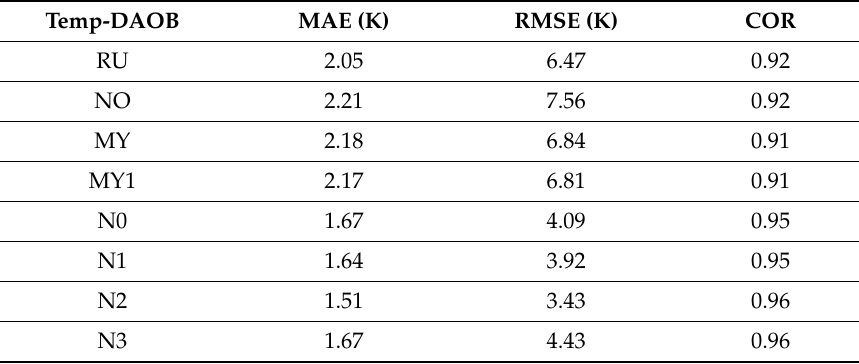
Table A6. Mean absolute error (MAE), root mean square error (RMSE), and correlation coe ffi cient (COR) for surface temperature (Temp) at Tiaret (Algeria); meteorological aviation reporting (METAR) station code =